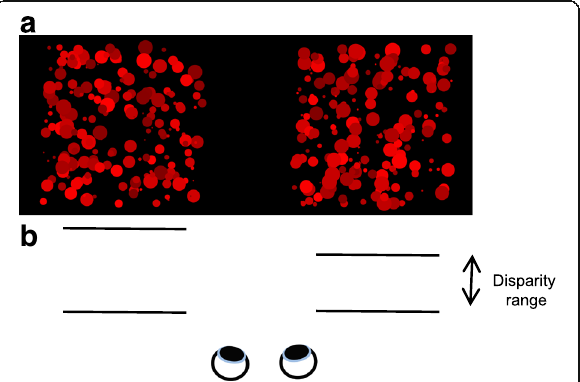
Fig. 1 Example of the stimuli used. a The random-circle stereogram stimuli used. b For each of the stereograms the dots were presented on two planes, separated in depth. The observer ’ s task was to choose whether the stimulus on the left or the right contained the greatest depth separation or the greatest sense of depth realism. See text for the details of the stimuli used in each